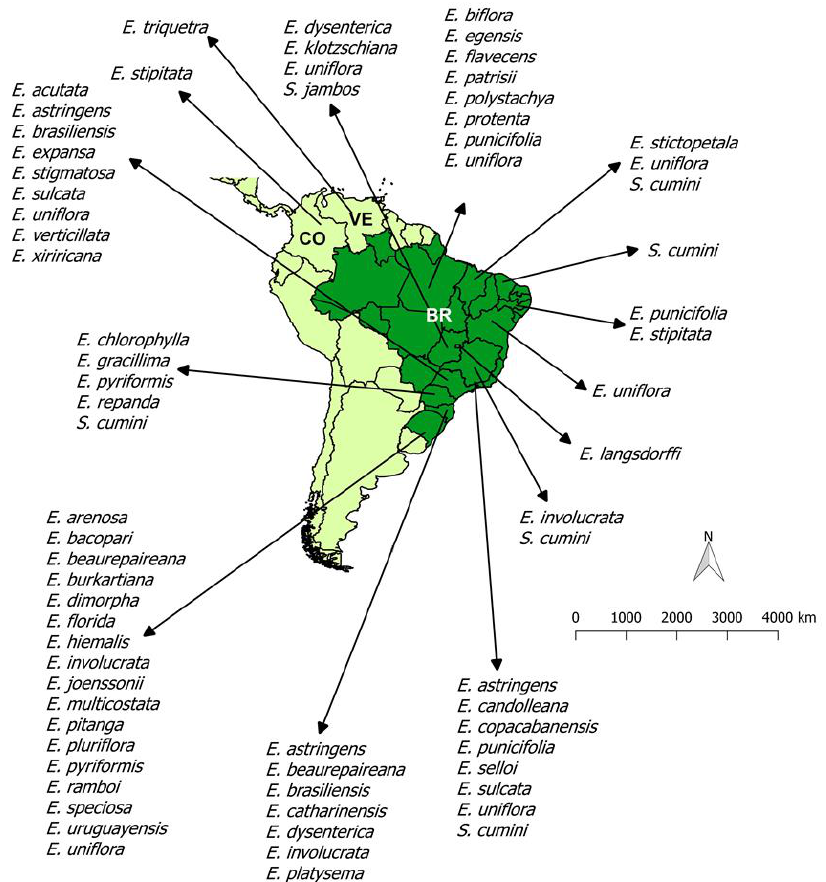
Figure 1. Geographical distribution in South America of Eugenia and Syzygium specimens based